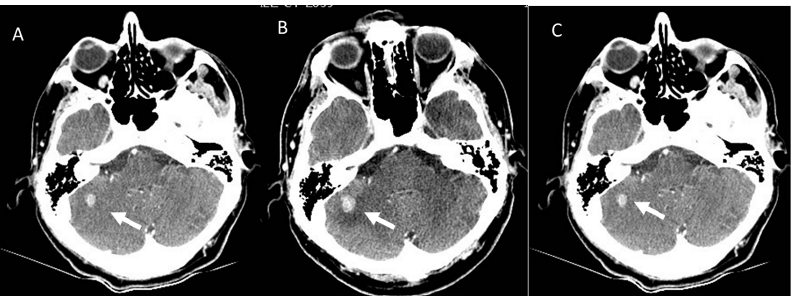
Figure 3. Pseudoprogression of brain metastasis (arrows) in an NSLC patient treated with immunotherapy. CT evaluation ( A ) in pre-treatment phase, after 1 month ( B ), and after 12 weeks of the first CT evaluation ( C ).